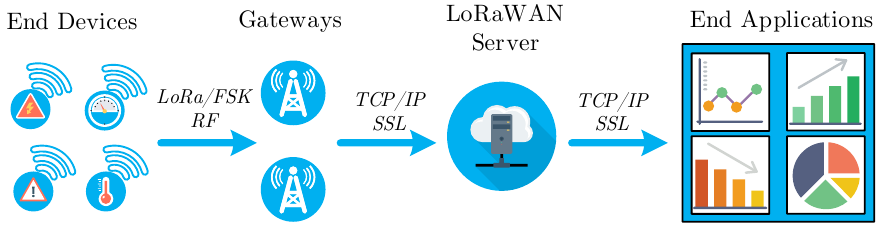
Figure 2. Architecture of the LoRaWAN from the end-device to